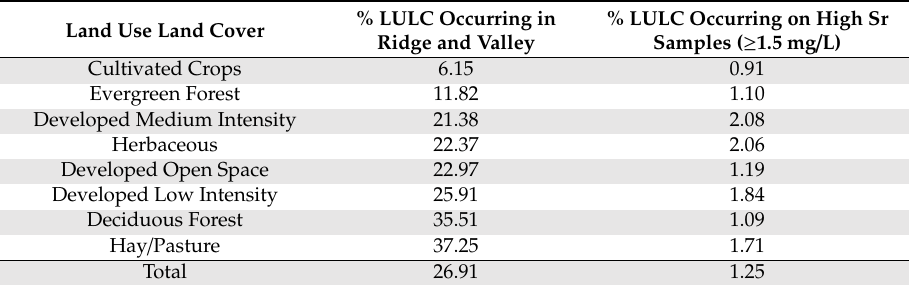
Table 3. Results of land use land cover (LULC) analysis.